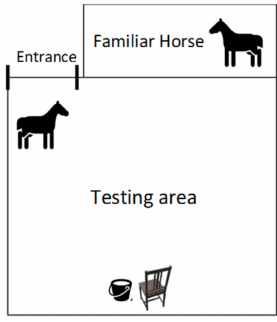
Figure 1. Scheme of the testing area. This setting was designed to test horse reactivity to di ff erent stimuli, while avoiding social